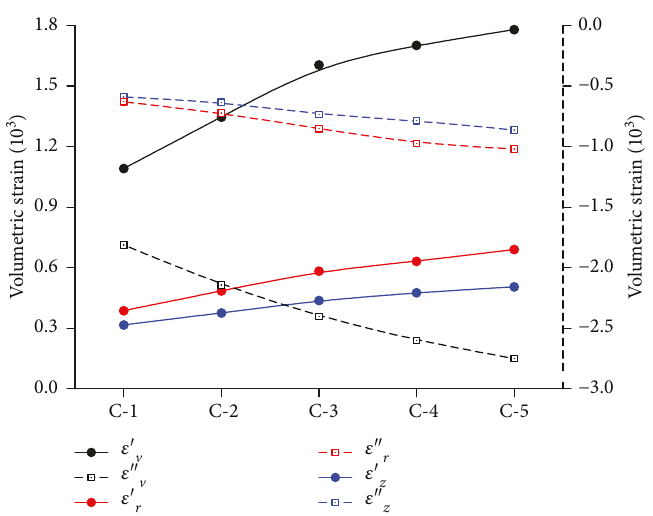
Figure 6: Maximum compressive deformation and maximum expansion deformation.